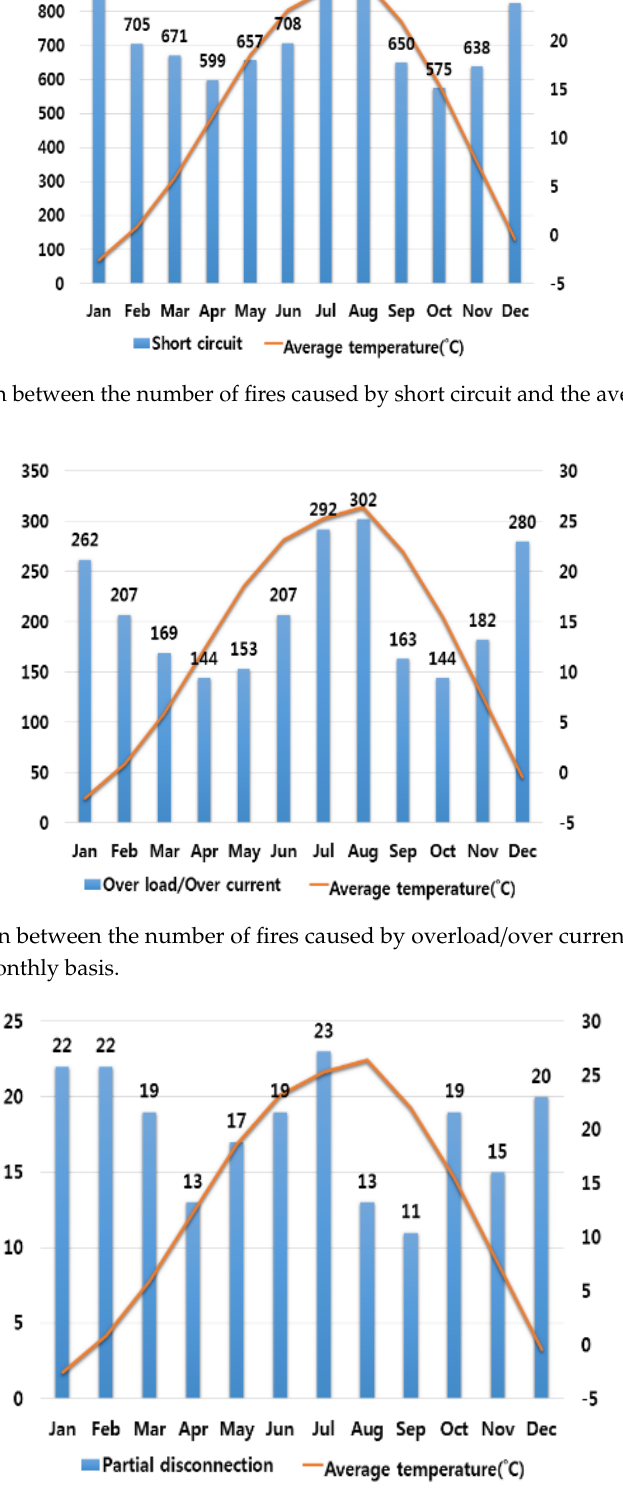
Figure 4. Correlation between the number of fires caused by partial disconnection and the average temperature on a monthly basis.